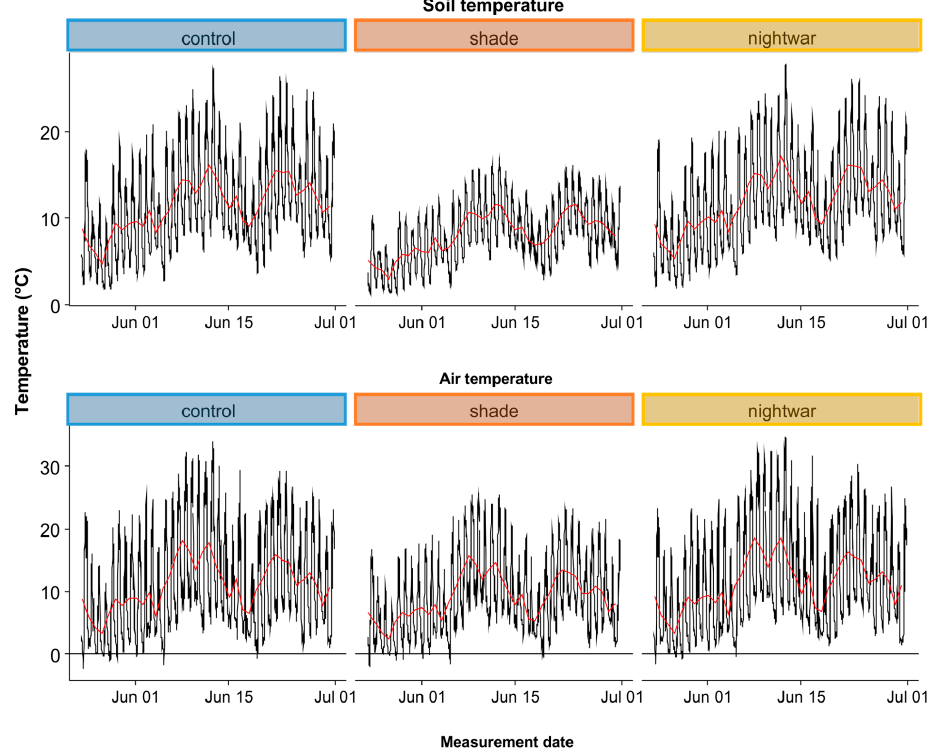
Figure 2. Temperature at 5 cm below (top graphs) and 10 cm above (bottom graphs) the bare soil surface in three experimental treatments near the treeline in the French Alps: control (no roof), shade (shade roof during the day), and nightwar = night warming (shade roof during the night). Shown are mean values of three temperature sensors (in three blocks) per treatment.